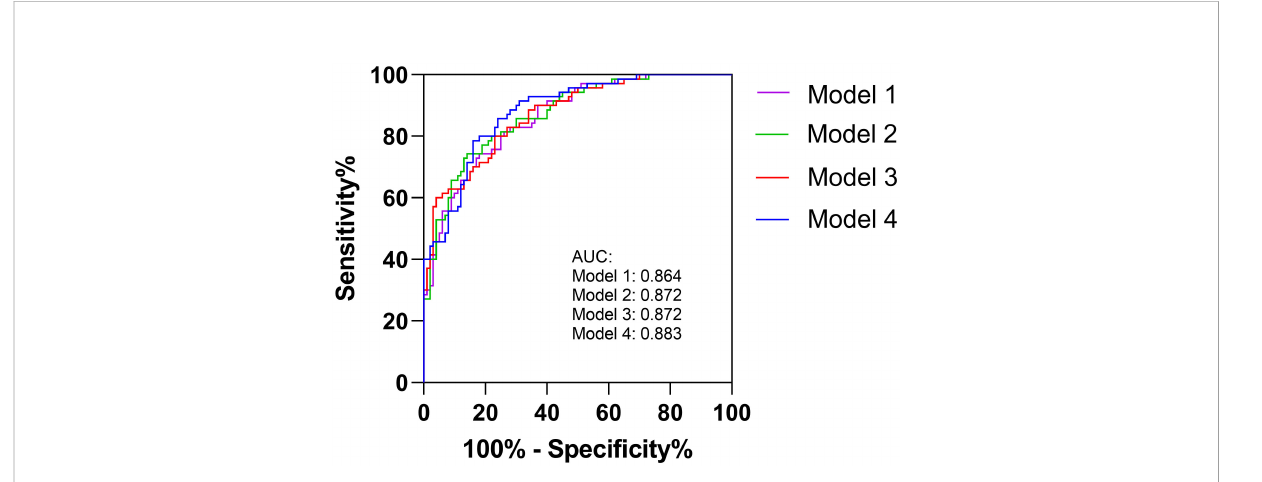
FIGURE 2 The AUCs for conventional model (Model 1) and conventional model with NLR parameters (Model 2, Model 3 and Model